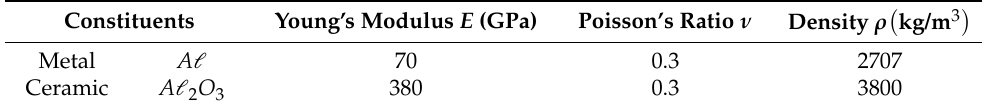
Table 1. Material properties of metallic and ceramic